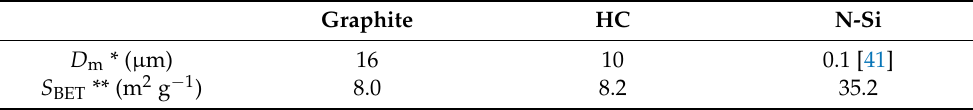
Table 1. Physical properties of the active materials used for anode fabrication. Graphite HC N-Si